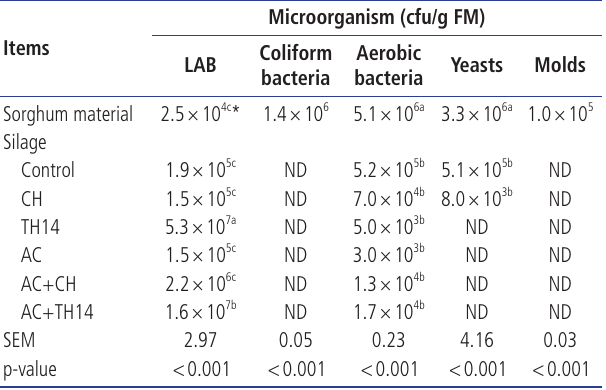
Table 1. Microorganism counts of sorghum prior to ensiling and its silages at